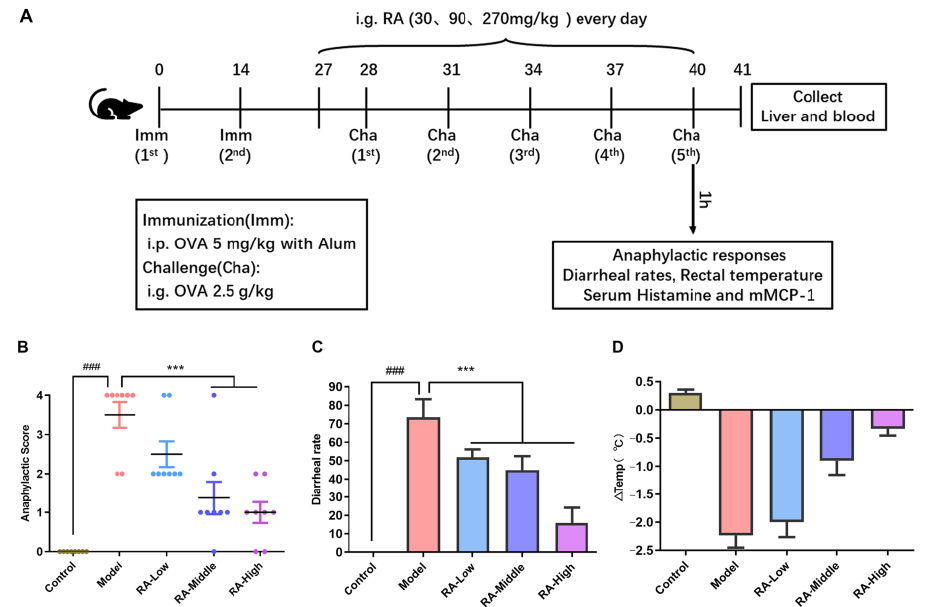
Table 1. Allergy symptoms.